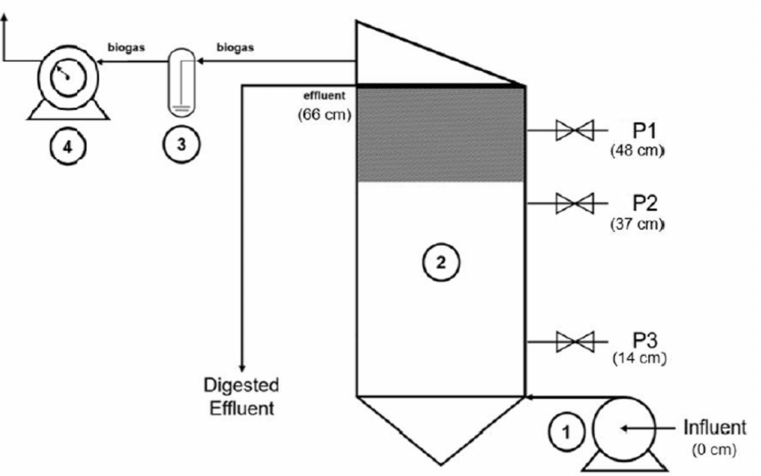
Figure 1. The experimental set scheme of the hybrid anaerobic reactor: (1) peristaltic pump for effluent feeding, (2) hybrid reactor, (3) liquid trap, (4) mechanical gas meter. Sampling ports: P3 (14 cm), P2 (37 cm), P1 (48 cm), Effluent exit (66 cm). BWW and PE were mixed at proportions of 60% BWW and 40% PE ( v / v ) and fed as